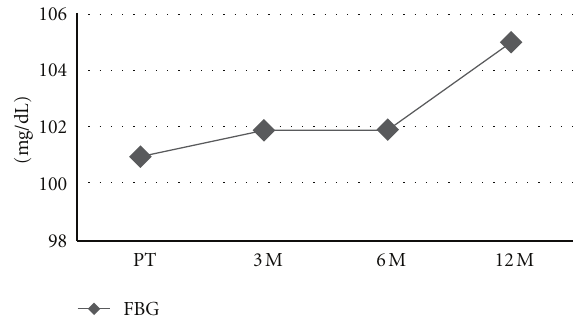
Figure 1: Fasting blood glucose levels during 12-month ADT. FBG: fasting blood glucose, PT: pretreatment, 3 M: 3-months; 6M: 6 months; 12M: 12 months.